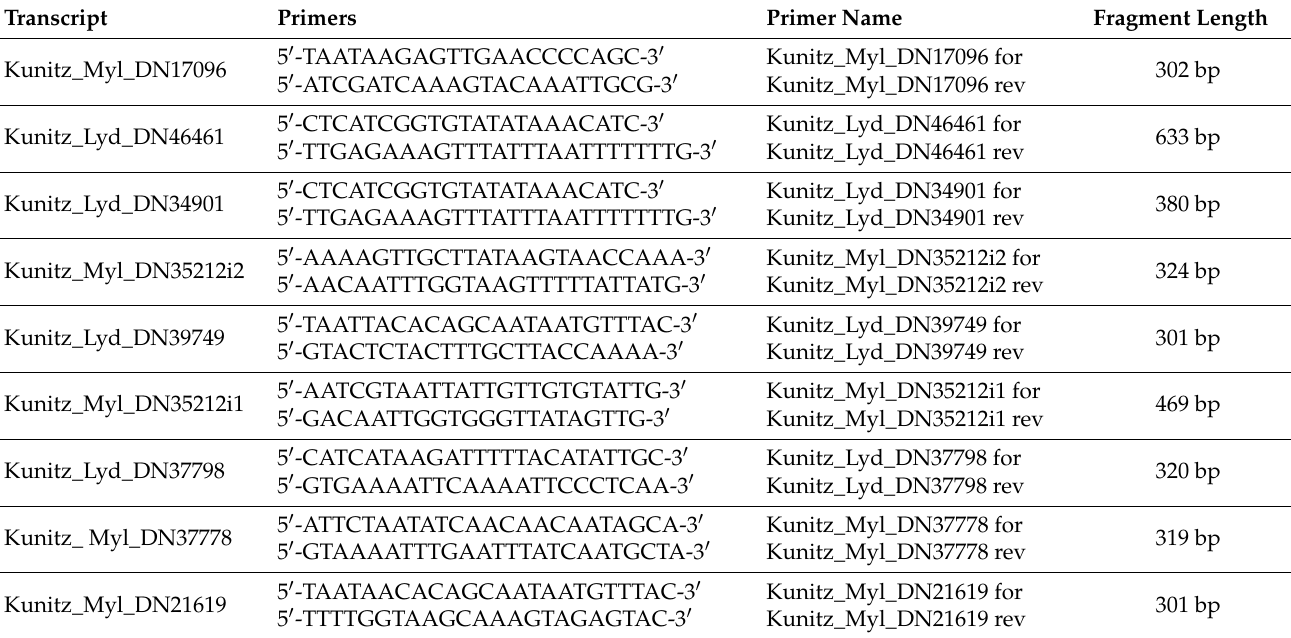
Table 1. Table list of the primers used for each specific